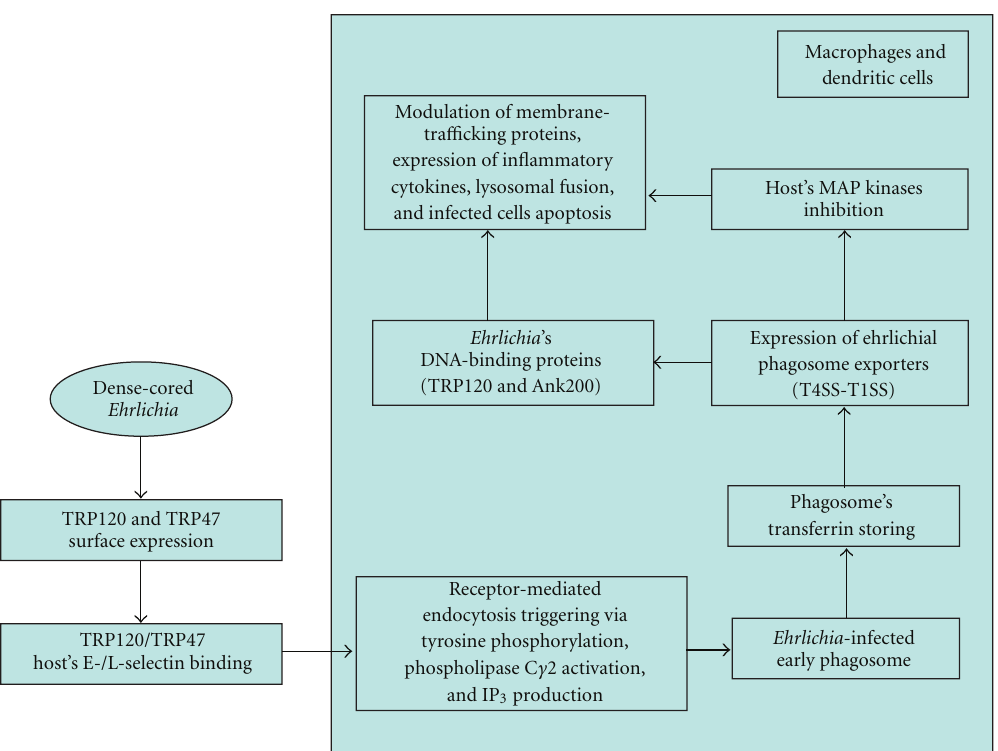
Figure 11: Ehrlichial monocytes/macrophages and dendritic cells